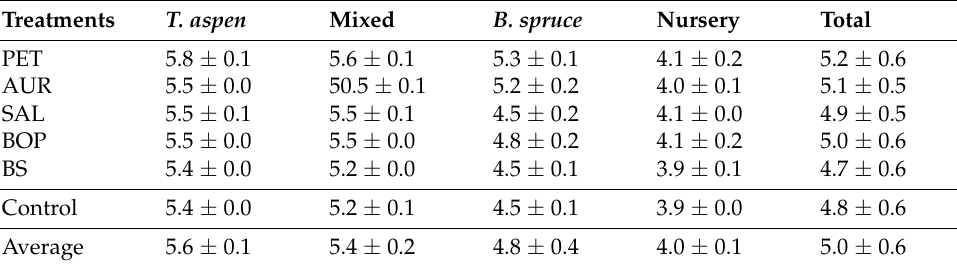
Table 4. Final pH ± SD according to the humus treatments with different litter types added. Treatments T. aspen Mixed B. spruce Nursery